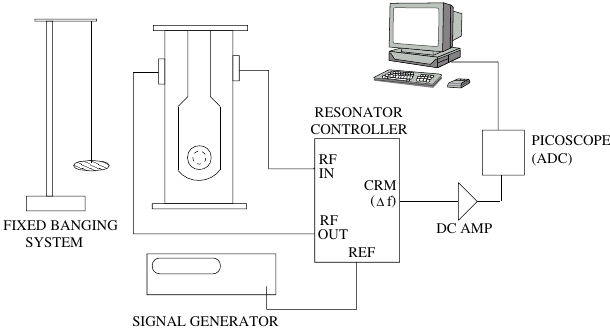
FIG. 2. Block diagram to measure frequency excursion of a resonator with the help of the cavity resonance monitor.